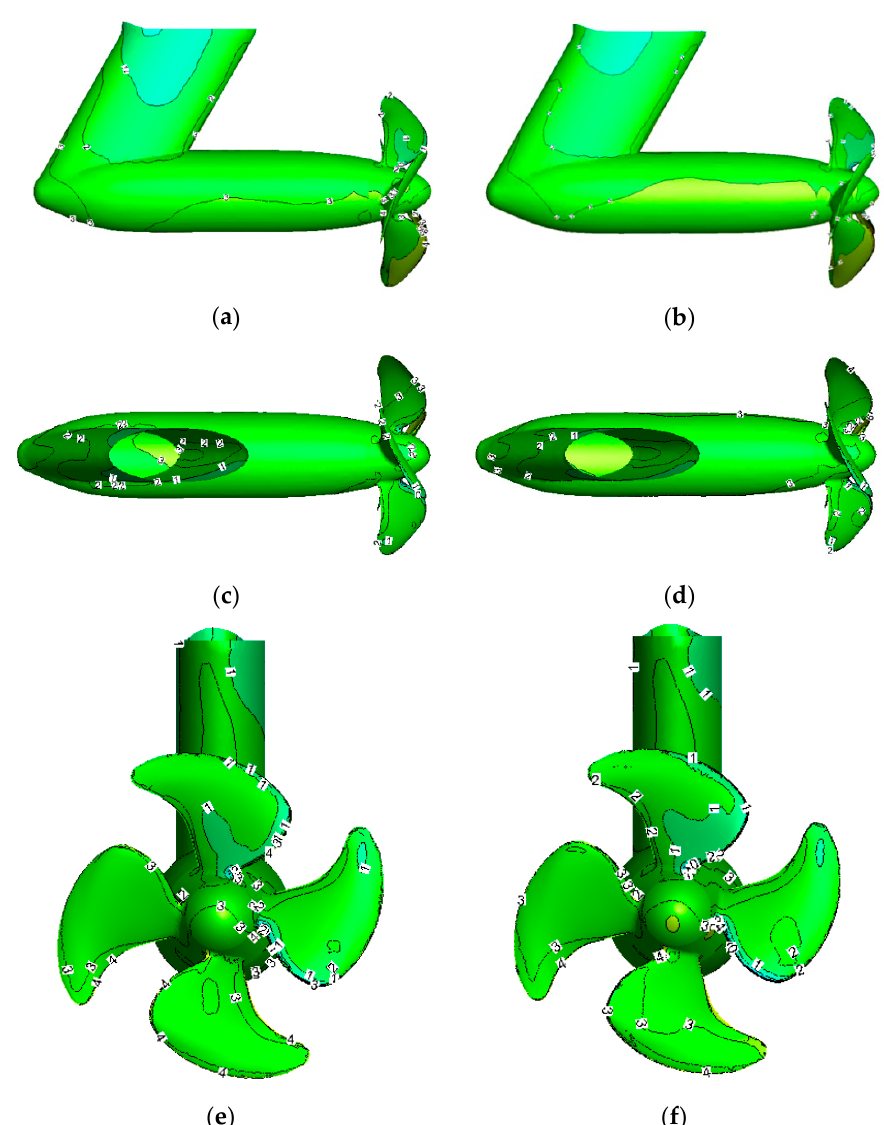
Figure 9. Pressure distributions of the full scale and the model scale cases: ( a ) Full-scale side view (left pod); ( b ) model-scale side view (left pod); ( c ) full-scale top view (left pod); ( d ) model-scale top view (left pod); ( e ) full-scale front view (left pod); ( f ) model-scale front view (left pod).